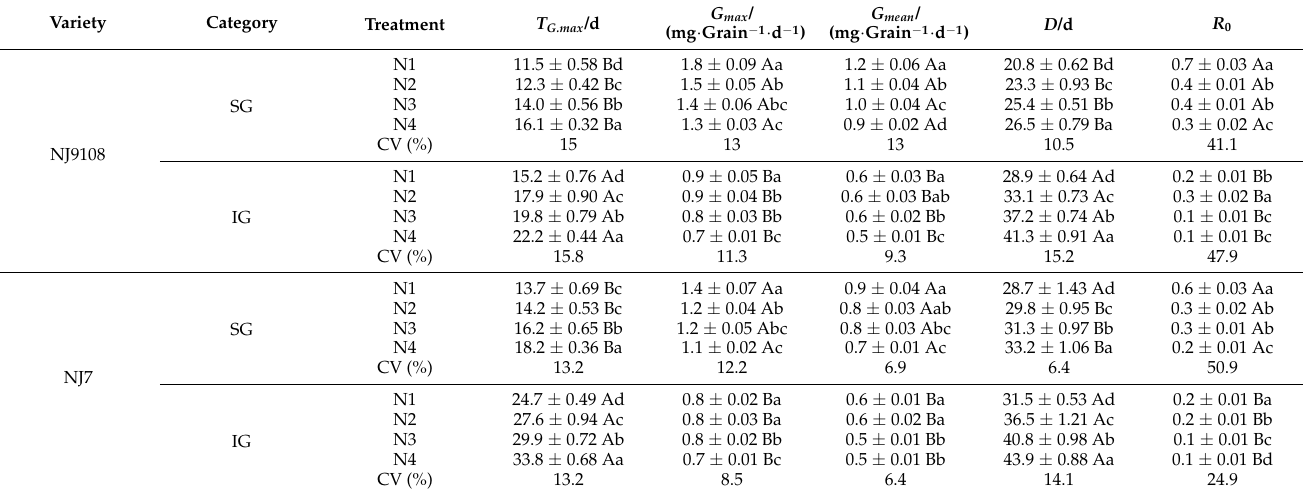
Table 6. Parameters of grain-filling characteristics of superior and inferior grains.